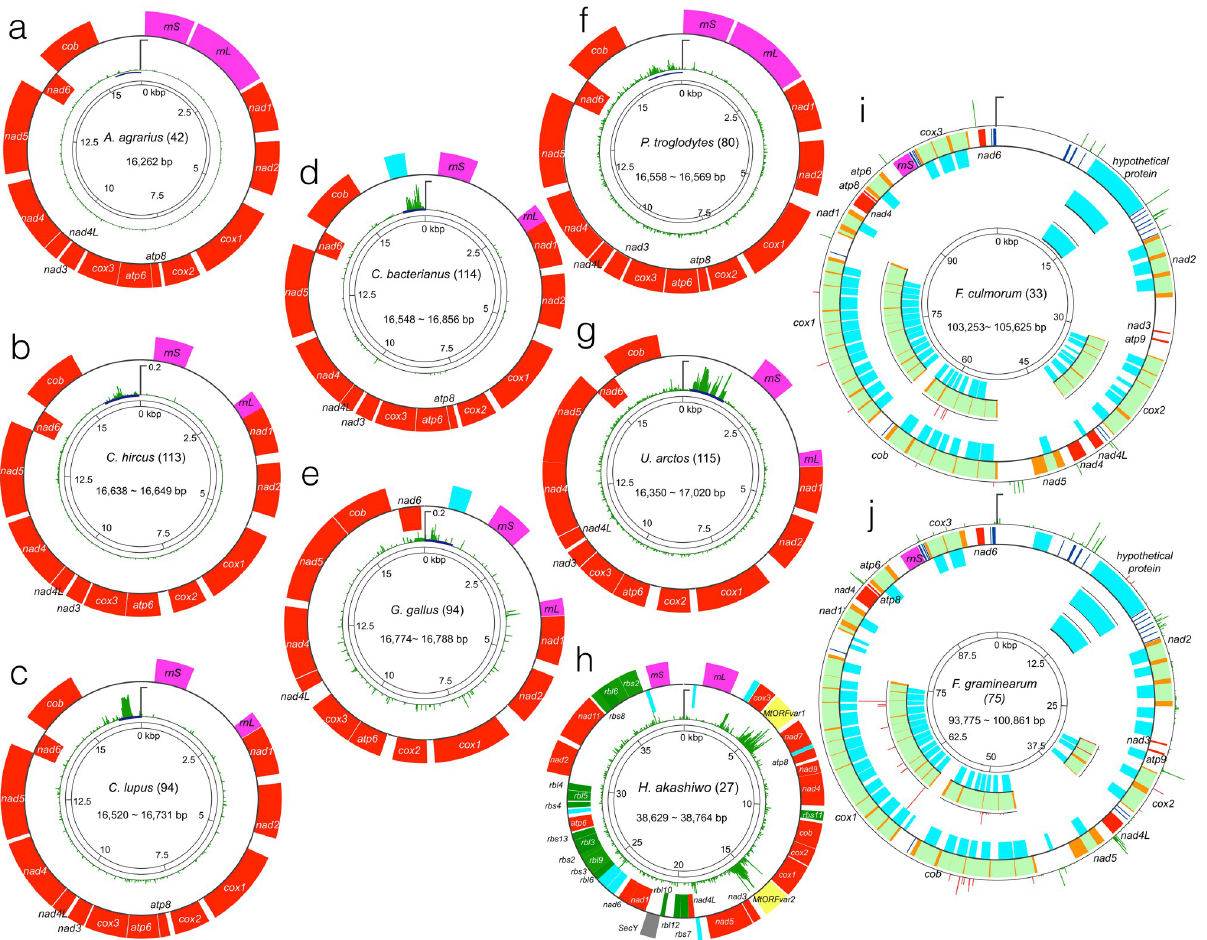
Fig 2. Genetic components (colored arcs) and sequence heterogeneities (green and red flairs) of the analyzed mtDNAs. Genes with different predicted functions are color-coded as follows: Respiratory genes, red; ribosomal subunit proteins, blue; SecY-independent transporter (SecY), grey; ribosomal RNA subunits, green; hypothetical proteins, cyan; MtORFvar1 and MtORFvar2, yellow; and ribosomal RNAs, pink. Introns and exons of respiratory genes are color-coded with pale green and orange, respectively, and tRNA-coding sequences are shown as dark blue bars in I) F . culmorum and J) F . graminearum . Genes coded by positive strands and negative strands in A-H are shown outside and inside arcs, while all of the ORFs in two fungal species (I and J) are coded by positive strands, and ORFs that are coded by the introns are shown as inside arcs. The gene name abbreviations are as follows: Ribosomal RNA large subunit, rnL ; ribosomal RNA small subunit, rnS ; cytochrome c oxidase subunit, cox ; NADH dehydrogenase subunit, nad ; ATP synthase F0 subunit, atp ; ribosomal protein small subunit, rbs ; ribosomal protein large subunit, rbl ; and cytochrome b, cob . Scales for nucleotide positions are represented as grids and are numbered clockwise. The sequence heterogeneities among all sequences analyzed for the organisms are shown in green flair, while the heterogeneities among sequences with exon/intron organization variants and truncated versions of hypothetical proteins in F . culmorum and F . graminearum are shown in red. The scales for heterogeneities correspond to H = 0.5 unless otherwise